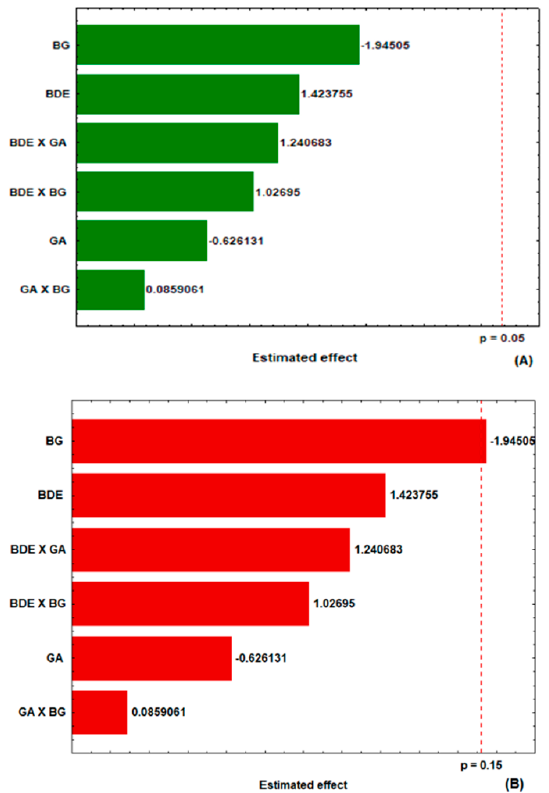
Figure 1. Estimated effects of the concentrations of β -glucan (BG), gum arabic (GA), and B. dracunculifolia extract (BDE) on the encapsulation yield of the microparticles at the 95% ( A ) and 85% ( B ) confidence levels.